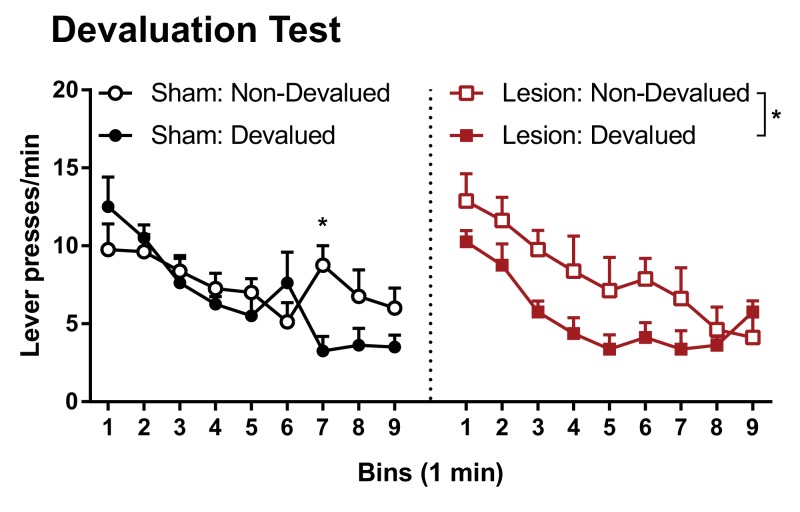
The effects of excitotoxic OFC lesions on instrumental devaluation by taste aversion.Within-session responding during test session, presented in 1 min time bins. Responding in all conditions was minimal during minute 10 and has been excluded. Error bars depict + SEM. There were significant devaluation effects in both lesion conditions, however they were expressed differently over time. Specifically, the devaluation effect was more persistent across time in the Lesion groups than the Sham groups. A mixed Lesion (sham, lesion) x Devaluation (devalued, non-devalued) x Bin (9 bins of 1 min) ANOVA revealed a main effect of Devaluation (F(1, 28)=5.03, p=0.03), Bin (F(8, 224)=16.74, p<0.001) and Lesion x Devaluation x Bin interaction (F(8, 224)=2.53, p=0.01) (All remaining Fs <1.47, p>0.17). Follow up Devaluation x Bin ANOVAs for each lesion group revealed a significant main effect of Devaluation (F(1, 14)=4.81, p=0.046) and Bin (F(8, 112)=12.05, p<0.001) but no Devaluation x Bin interaction (F(8, 112)=1.32, p=0.24) for the Lesion group. In contrast, Sham group showed a significant main effect of Bin (F(8, 112)=6.98, p<0.001) and Devaluation x Bin interaction (F(8, 112)=2.66, p=0.01, and a significant Devaluation x Bin linear trend interaction F(1, 14)=6.97, p=0.02), but no significant main effect of Devaluation (F(1, 14)=0.79, p=0.39). Bonferroni corrected simple effects revealed significantly higher responding in the Non-Devalued Sham group than the Devalued Sham Group during the 7th minute (F(1, 14)=12.19, p=0.004, all remaining minutes failed to reach significance, Fs <2.73, p>0.12). Linear trend contrasts revealed significant negative linear decreases in lever responding over time Bins in the Sham Devalued group (F(1, 7)=126.03, p<0.001), but not the Sham Non-Devalued group (F(1, 7)=3.36, p=0.109). (*) Symbol denotes statistical significance of simple or main effects following a significant interaction.